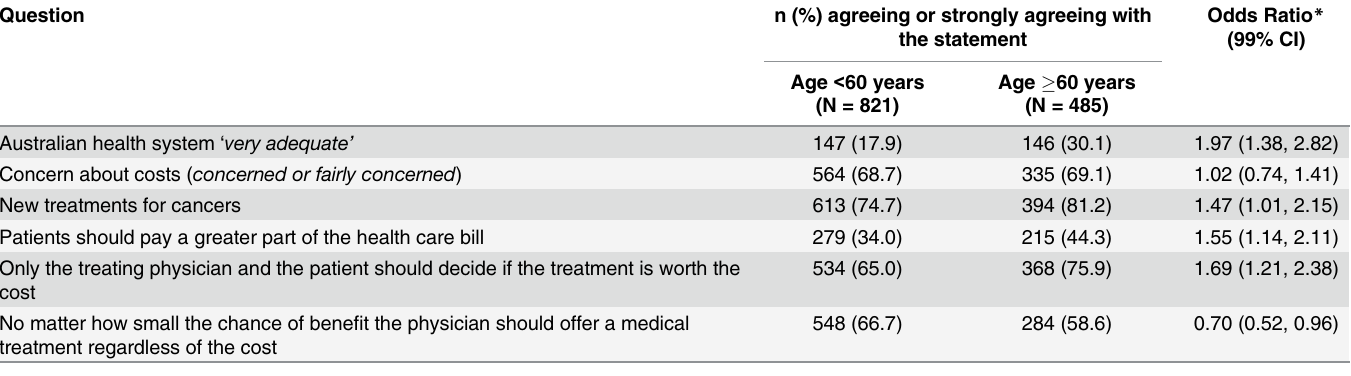
Table 5. Consumer responses by age group ( < 60 years; (cid:1) 60